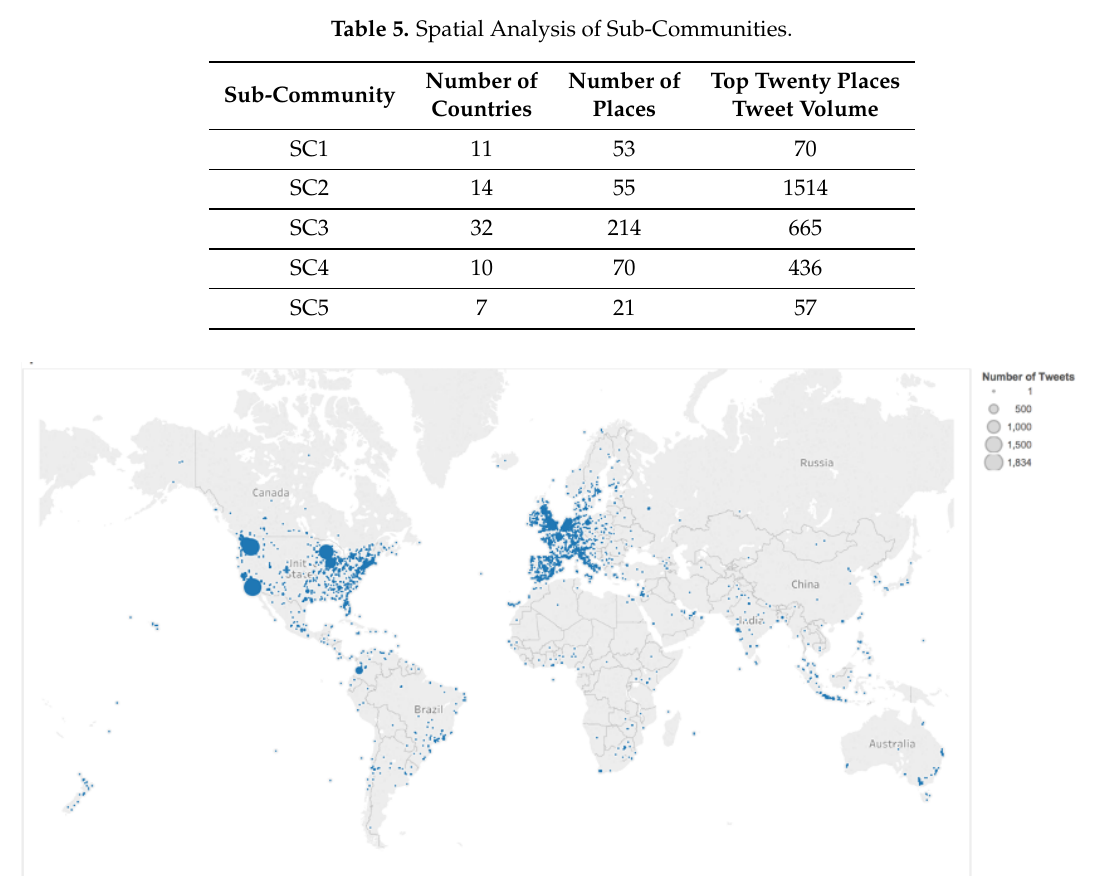
Table 5. Spatial Analysis of Sub-Communities.